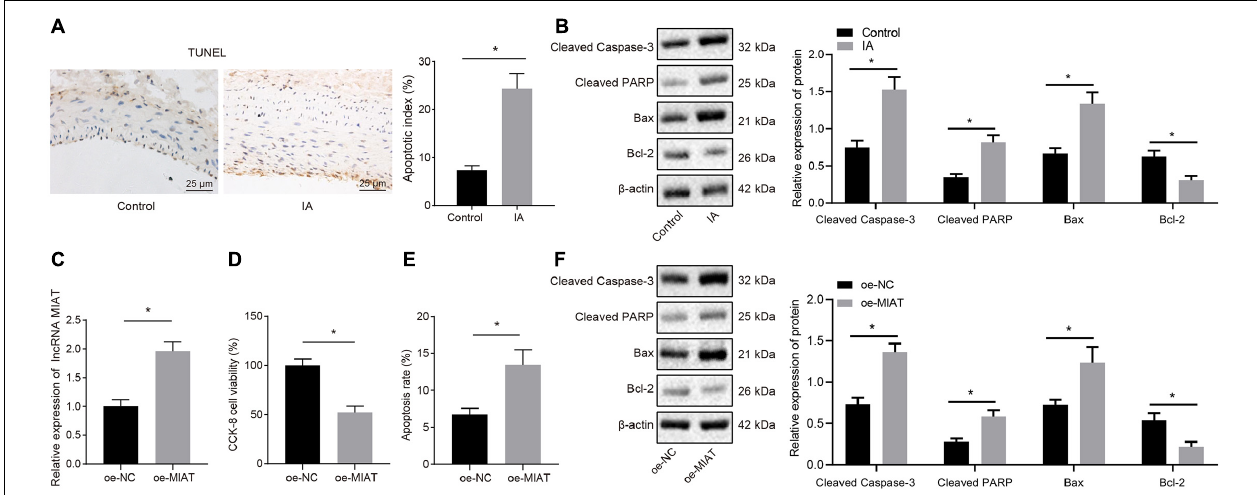
FIGURE 2 | The endothelial cell apoptosis can be induced by overexpression of MIAT in vitro . (A) Representative images of TUNEL staining ( × 200) and quantitative analysis of TUNEL-positive cells in patients with IA. (B) The expression of cleaved Caspase-3, cleaved PARP1, Bax, and Bcl-2 in patients with IA measured by Western blot analysis. (C) The expression of MIAT in endothelial cells after overexpressing MIAT determined by RT-qPCR. (D) Viability of endothelial cells in response to oe-MIAT detected by CCK-8 assay. (E) Flow cytometry analysis of apoptosis of endothelial cells in response to oe-MIAT. (F) The expression of apoptosis-related factors (cleaved Caspase-3, cleaved PARP1, Bax, and Bcl-2) in response to oe-MIAT measured by Western blot analysis. * p < 0.05. The measurement data were expressed as mean ± standard derivation. Comparisons between two groups were analyzed by unpaired t test, and the cell experiment was conducted three times